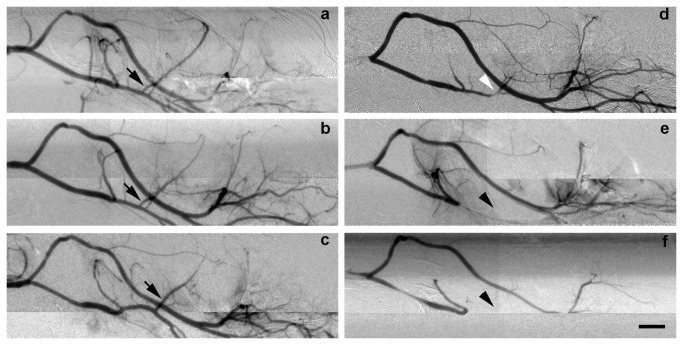
Mouse cerebral vascular morphology after tMCAO and at various time after reperfusion detected by SRA.SRA after 90 minutes of MCAO and at 0 (a), 1 (b) and 3 hours (c) after reperfusion in heparin-treated mice shows that the CCA, ICA, PPA, PCA, MCA and ACA could be clearly detected. In contrast, SRA after 90 minutes of MCAO and at 0 (d), 1 (e) and 3 hours (f) after suture withdrawal in heparin-free mice shows that the CCA, ICA, PPA and PCA could be clearly detected while the MCA and ACA could only be partially detected (d) or undetected (e, f). Arrows indicate that MCA was well filled with contrast agent Ipamiro. Black arrowheads indicate the location of MCA, which was undetectable. White arrowhead indicate the location of MCA, which was partially detected. Bar= 1 mm. ACA: anterior cerebral artery, CCA: common carotid artery, ICA: internal carotid artery, MCAO: middle cerebral artery occlusion, PPA: pterygopalatine artery, PCA: posterior cerebral artery, SRA: synchrotron radiation microangiography.